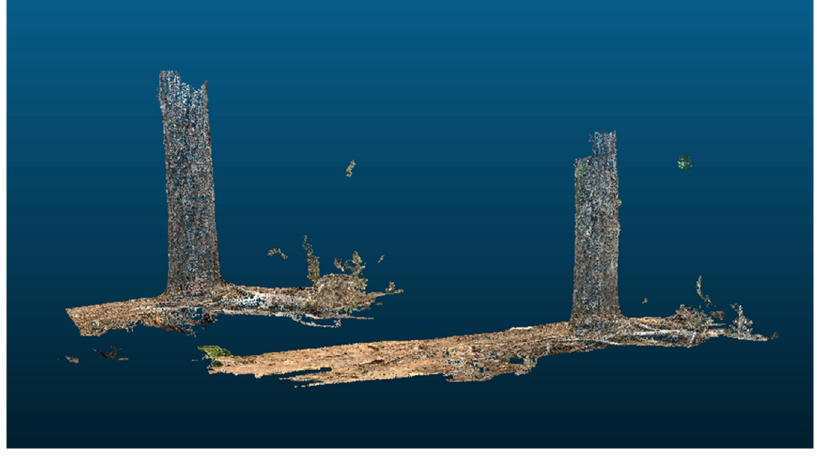
Figure 5. iPad LiDAR scanning error with one tree appearing as two separate trees.